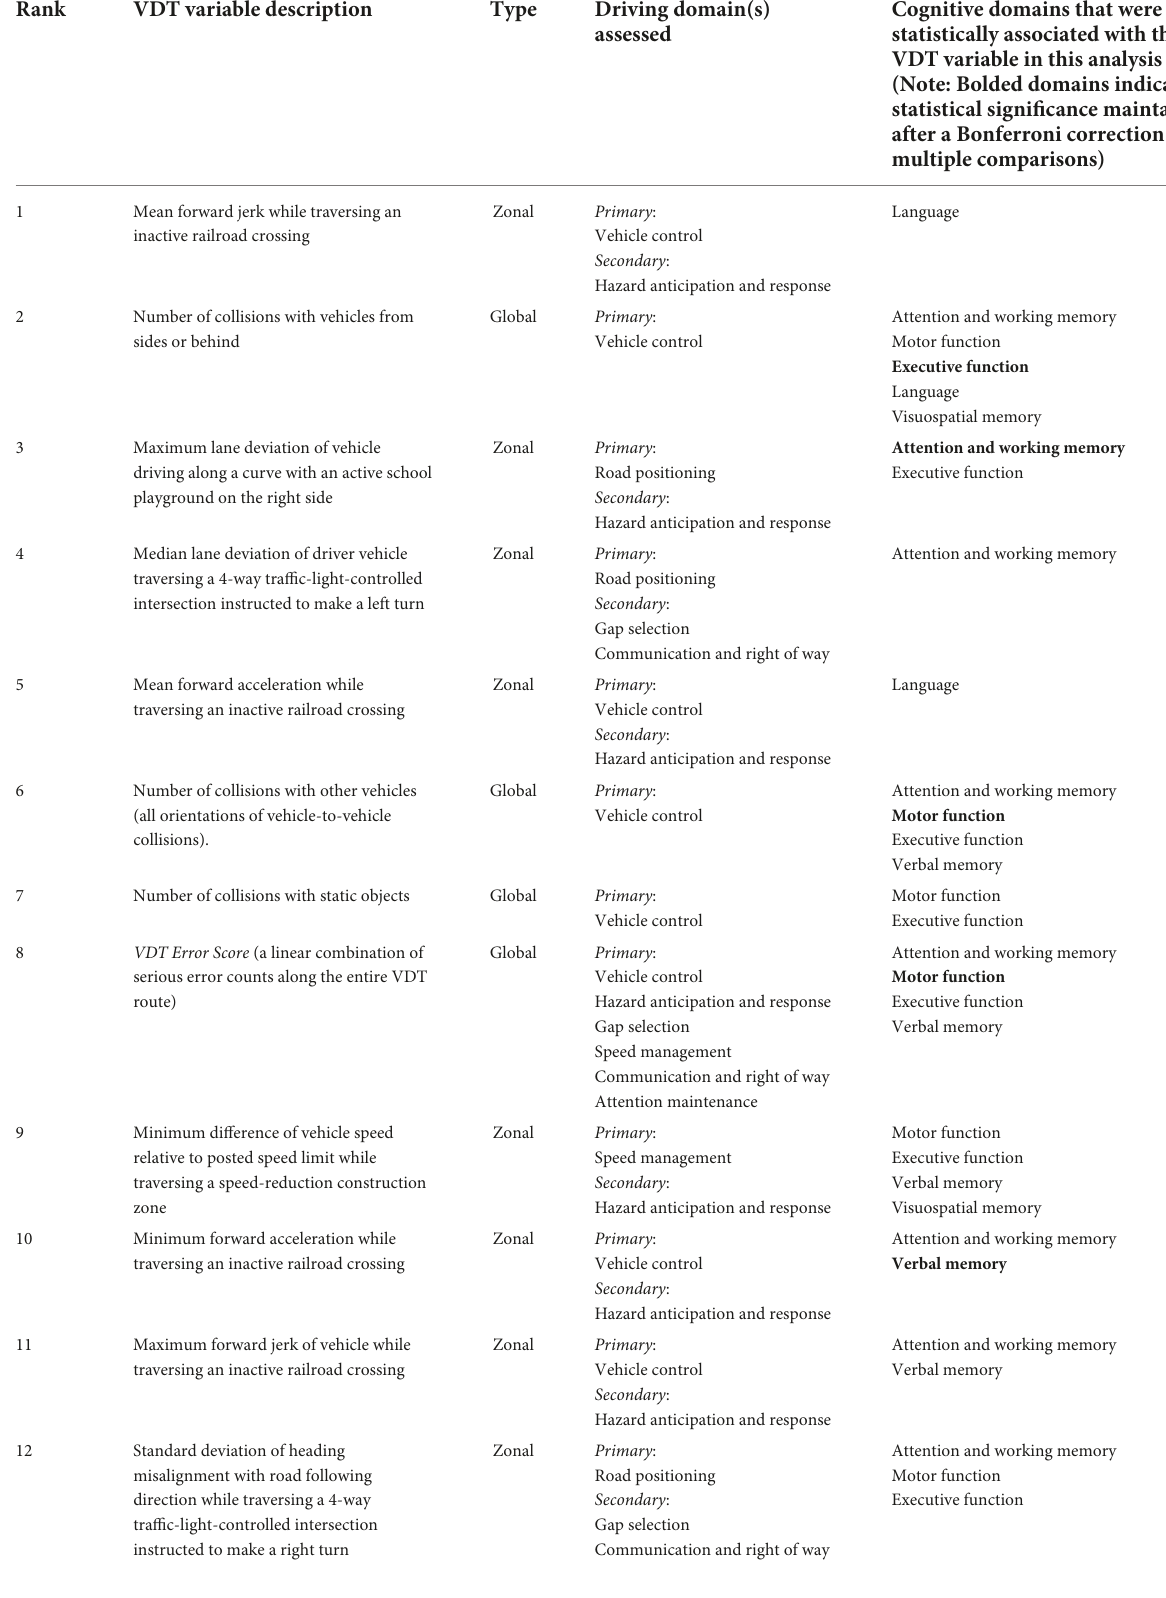
TABLE 5 The final 20 ranked consensus variables associated with HAND status. VDT variable description Type Driving domain(s)